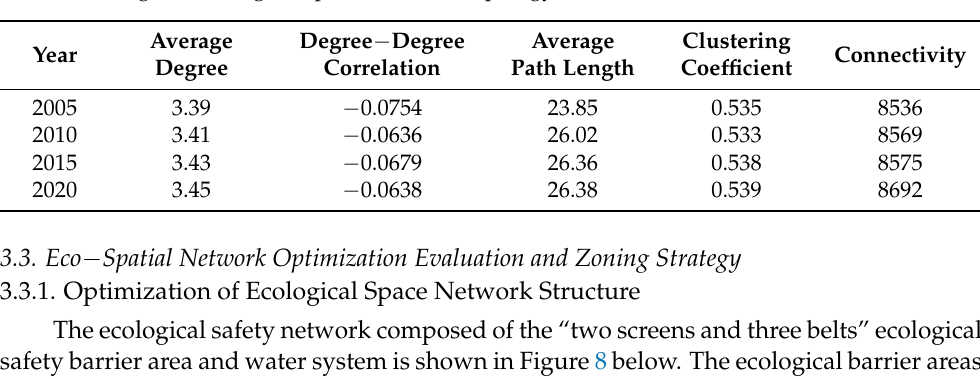
Table 4. Changes in ecological spatial network topology indicators from 2005 to